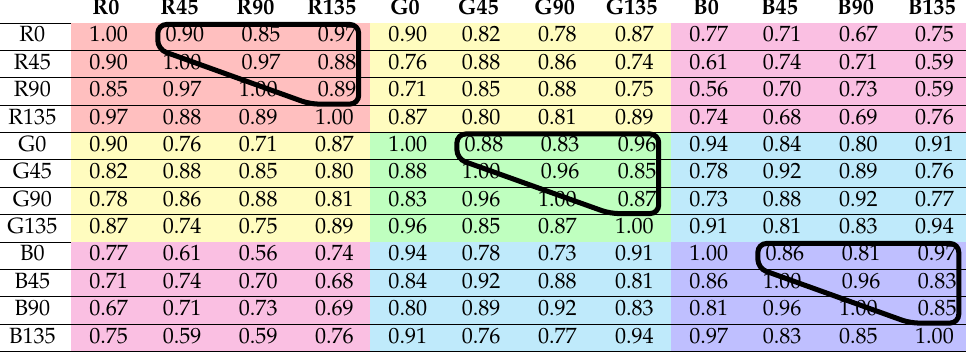
Table 3. Correlation results for the Total Object scenario, over all of the 12 channels grouped by spectral channel. The polarization groups of correlation coefficients (surrounded) are passed to the MWU computation. Channel groups are distinguished by different